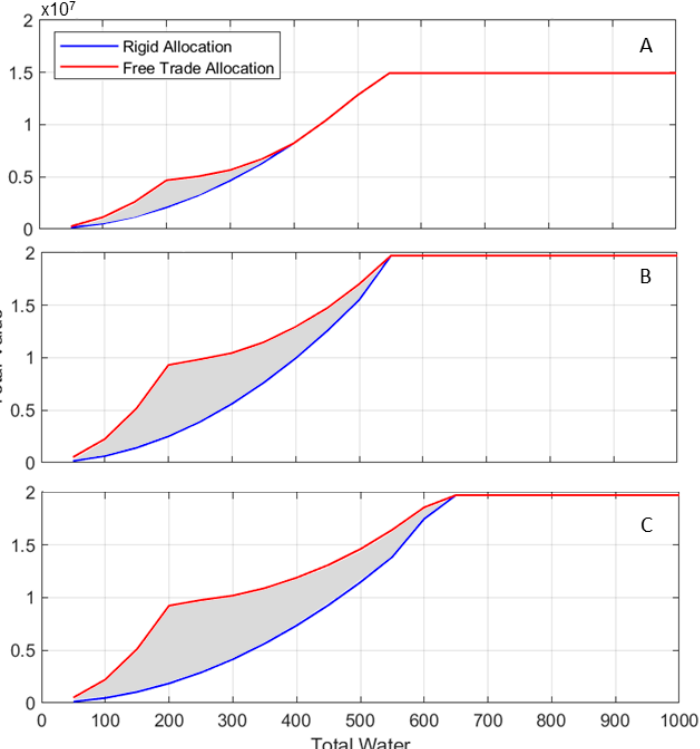
Figure 5. Comparison of attainable economic output under “maximum value” scenarios (red) vs. a scenario in which the upstream user focuses only on maximizing its own output (blue). In all cases, the downstream user generates higher economic output per unit of water than the upstream